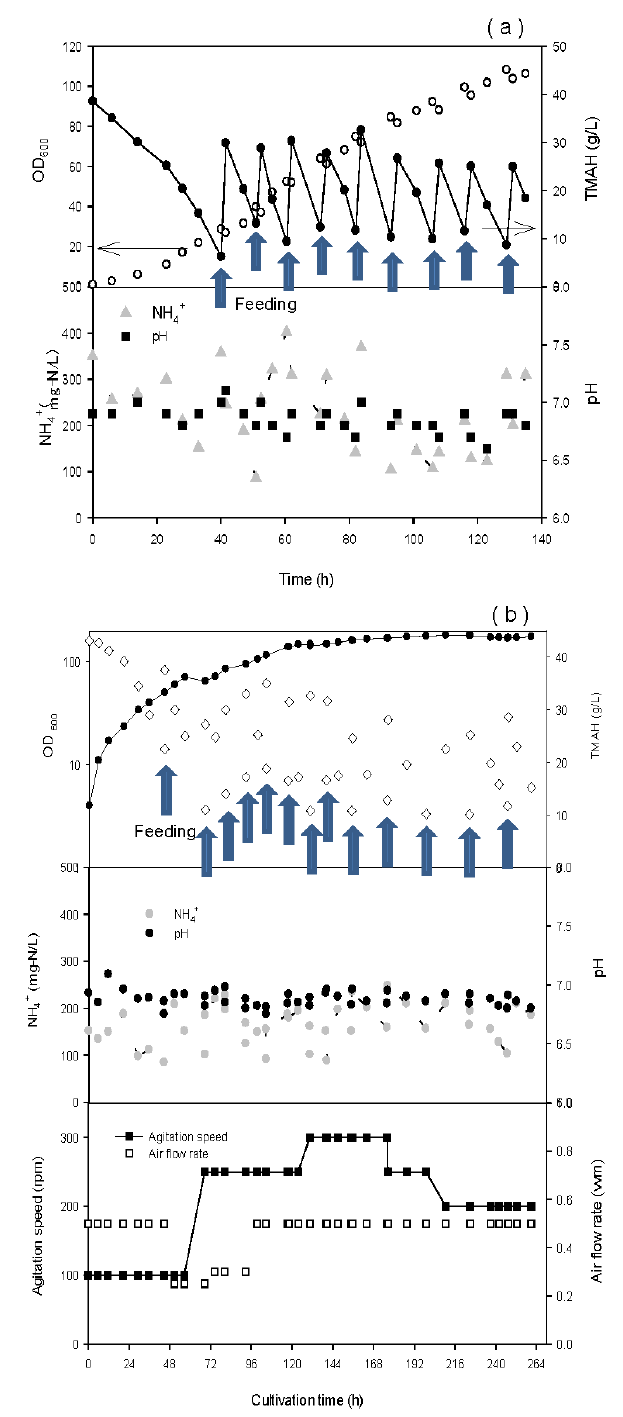
Figure 1. Cultivation of tetramethyl ammonium hydroxide (TMAH) degrading bacteria in ( a ) small scale (2.5 L) and ( b ) large scale (200 L).